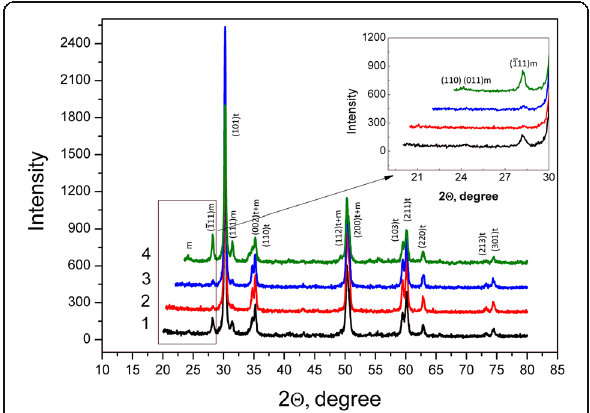
Fig. 1 The XRD patterns of nanopowders with and without silica additive: 1- PMM8-3Y-TZP-0.2 wt% SiO 2 ; 2 -3Y-TZP-0.2 wt% SiO 2 ; 3- 3Y-TZP; 4 -